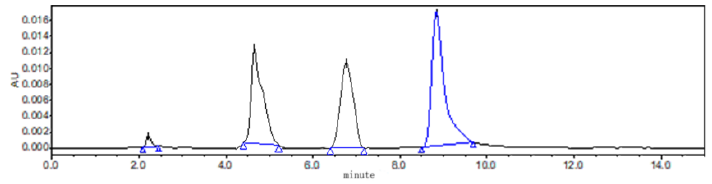
Figure 3. The chromatogram of ABZ, ABZSO and ABZSO2. For plasma sample treatment, 100 μ L of 0.1 mol/mL ammonia solution were added into 100 μ L serum sample under vortex. After shaking for 1 min, 2 mL acetonitrile and 2 mL ethyl acetate were added and then further vortex for 1 min followed by ultrasonication for 5 min. The mixture was centrifuged for 10 min at 5000 r/min, and the precipitate was re-extracted by adding 2 mL ethyl acetate. The mixed extraction solution of two times was dried under nitrogen at room temperature, and the residue was dissolved with 200 μ L methanol. The resuspension solution was centrifuged for 1 min at 4000 g (Hitachi Centrif- ugation CR21 GIII; Hitachi Koki Co., Ltd., Tokyo, Japan), and the supernatant, after filtra- tion through a 0.22-micron filter, was taken for HPLC analysis. Separation of chromato-